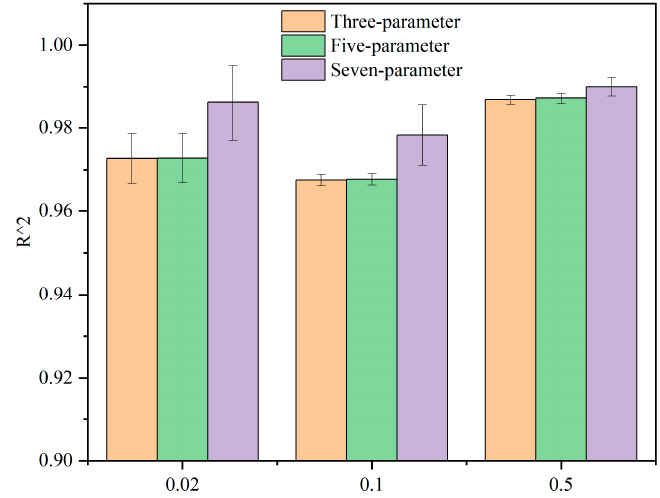
Figure 15. The fitting degree of the three viscoelastic models.